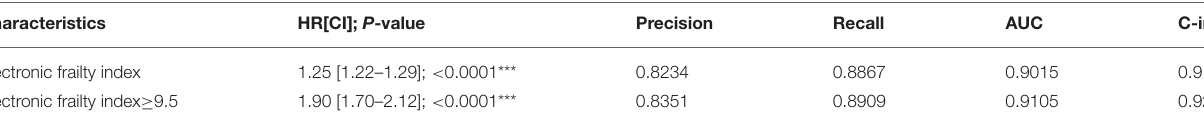
TABLE 3B | Prediction strength of electronic frailty index for all-cause mortality risk prediction.